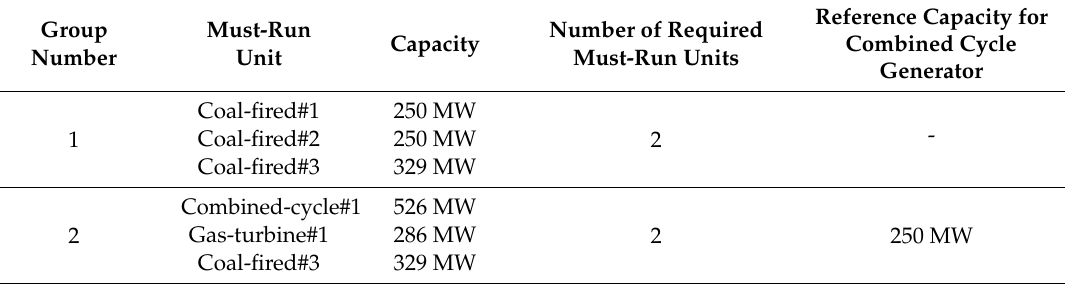
Table 2. Must-run unit information.